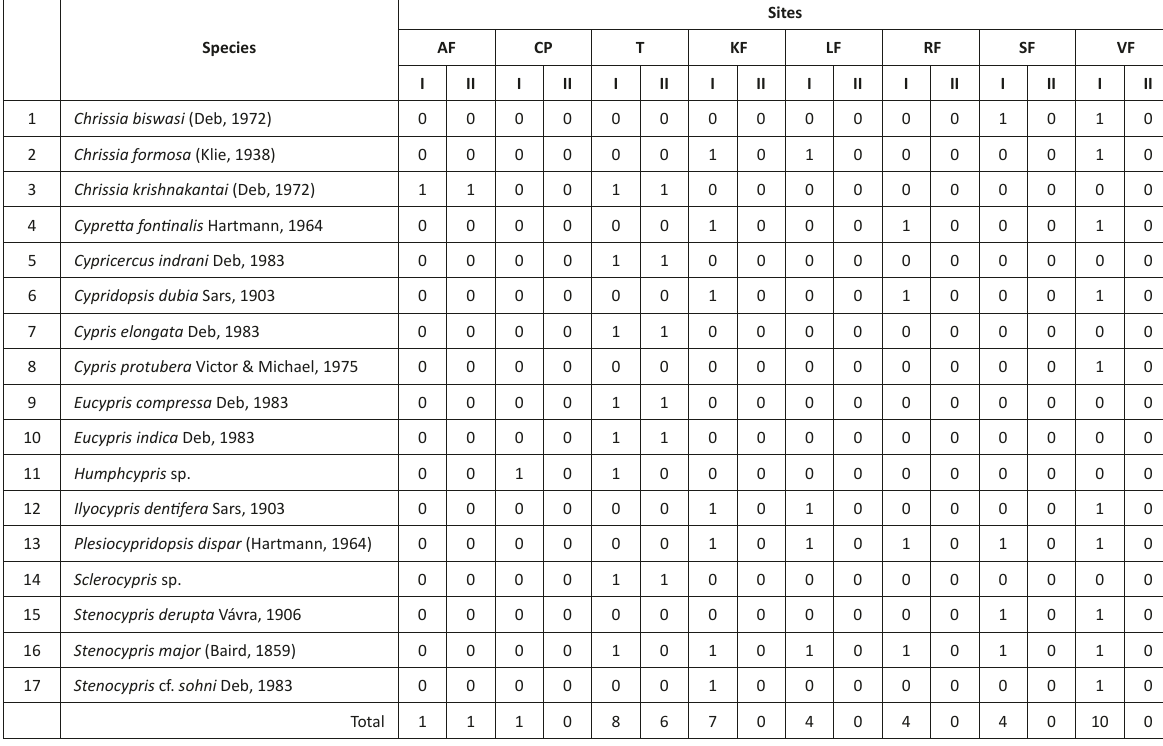
Table 2. Ostracods known from various rocky